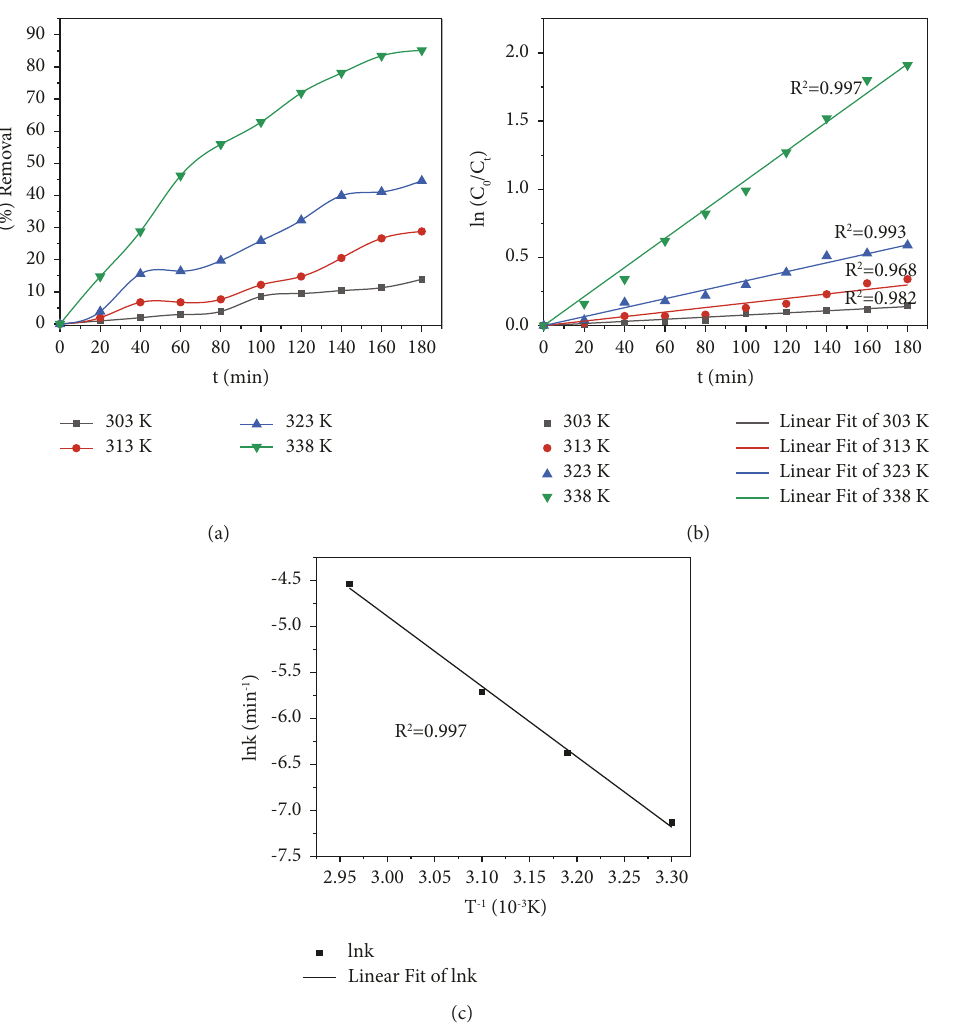
Figure 4: (a) Effect of temperature on the rate of removal of MO. Experimental conditions [MO] � 30 mg. L − 1 , pH � 4, mass of WO 3 � 0.25 g. (b) Effect of temperature on the first-order kinetic of MO removal. (c) Arrhenius plots of MO degradation.